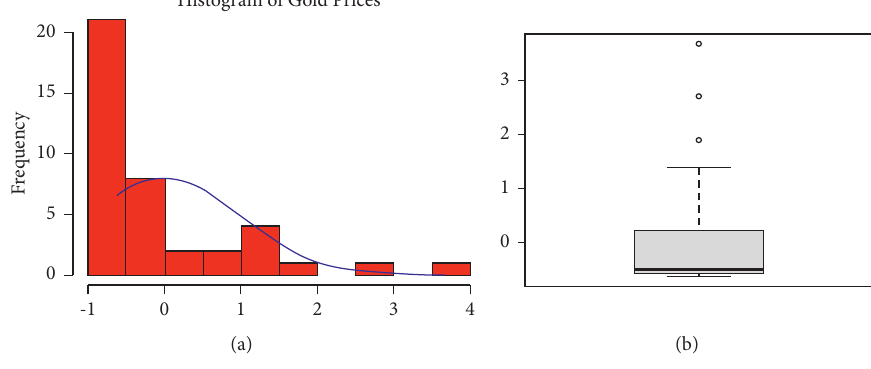
Figure 2: Histogram and boxplot of gold prices. Table 5: Features selection based on real data.